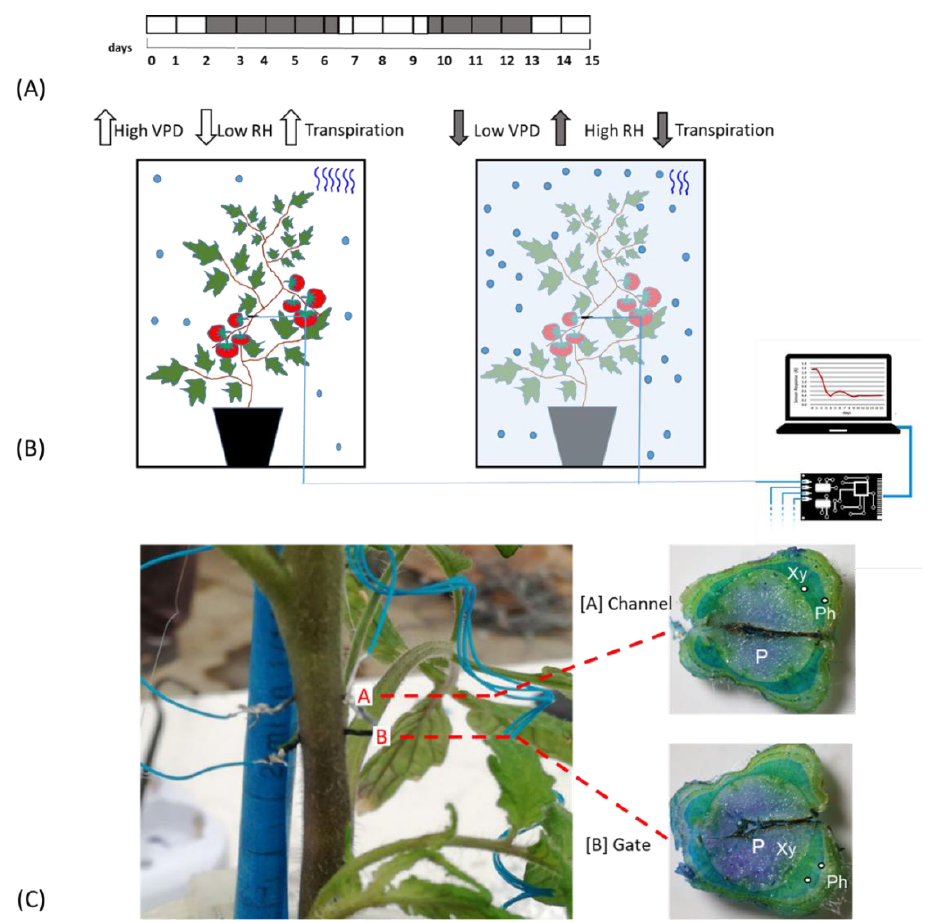
Figure 1. Experimental Outline. ( A ) Time line of the experiment. White blocks indicate the days in which plants are under normal VPD (0.1 and 0.8 kPa); grey blocks indicate the days of low VPD value (between 0.0 and − 0.1.; ( B ) Scheme of the bioristor measurements in high (left) and low (right) VPD conditions, the increases or decreases in the expected transpiration rate is also indicated as blue wave in the box; ( C ) Bioristor insertion in a tomato plant: A, channel and, B, Gate. The sections of the stem indicating the tissues crossed by the bioristor are reported and the vascular tissue interested by the bioristor are indicated P, pith; Xy, xylem; Ph, phloem.